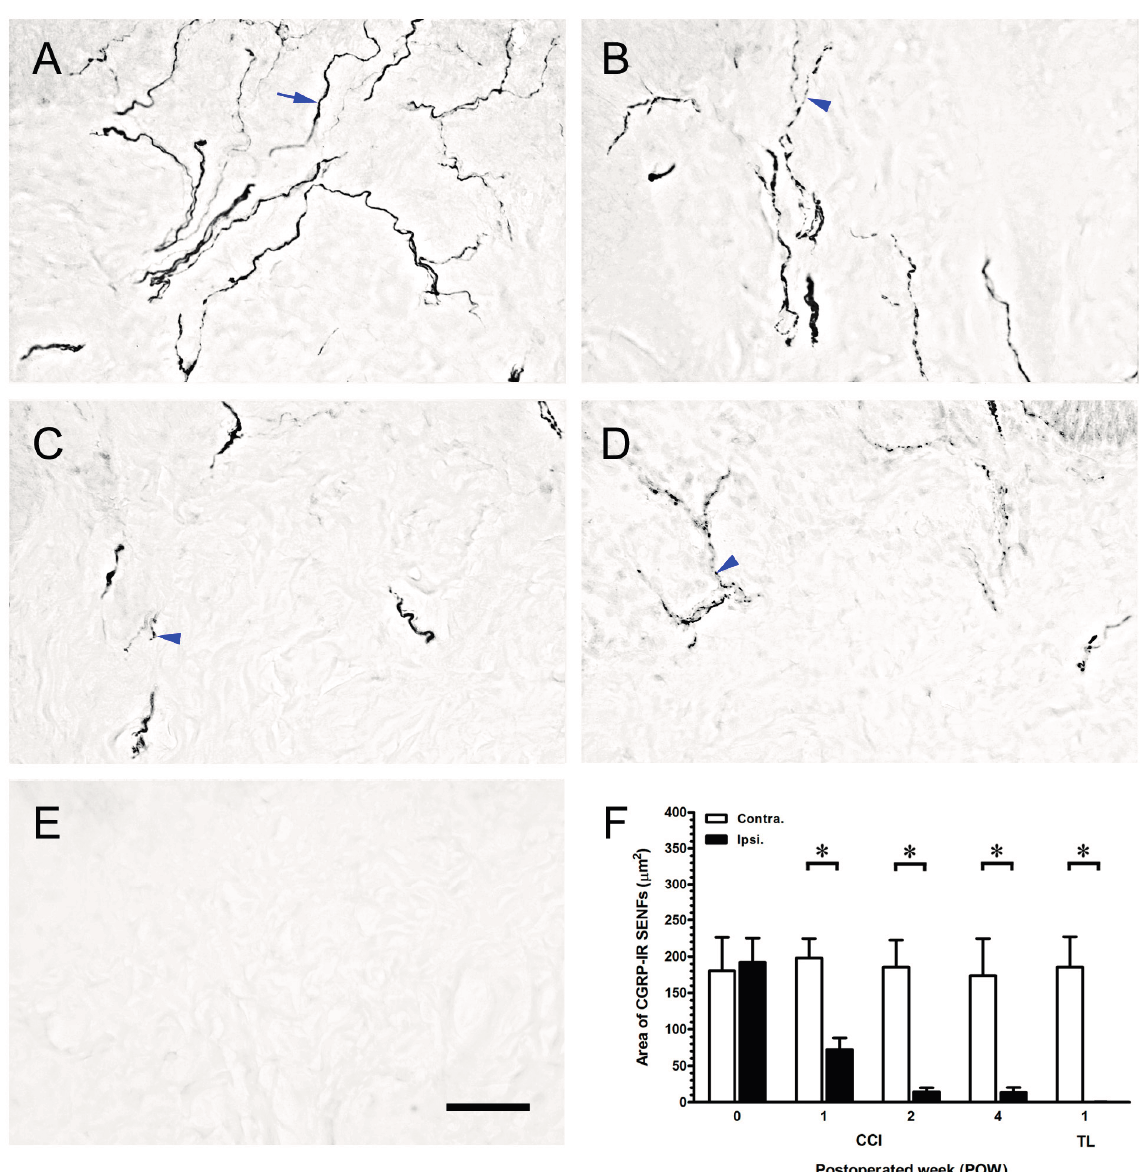
Figure 3. Influences of nerve compression injury on calcitonin gene-related peptide (CGRP)-IR SENFs in dermis. The ipsilateral sides of footpad skin from ( A ) sham-operated surgery, ( B – D ) CCI, and ( E ) TL were immunostained with antibody against CGRP. ( A ) Irregular linear CGRP-IR SENFs in normal dermis were towards the epidermal-dermal junction (blue arrow); Temporal changes of dermal expression were exposed at ( B ) POW 1, ( C ) POW 2 and ( D ) POW 4, and CGRP-IR SENFs had obvious beaded and swollen fragments after CCI (blue arrowhead); ( E ) Entire CGRP-IR SENFs loss was presented after TL at POW 1. Scale bar = 25 μ m; and ( F ) The areas of CGRP-IR SENFs were quantified as the mean ± SD ( n = 5 at each time points after CCI, n = 5 at POW 1 after TL). Each bar of values showed in the contralateral sides (Contra., open bars) and ipsilateral sides (Ipsi., filled bars). Student’s t test was applied to examine the differences between the Contra. and Ipsi. at the same time points. * p < 0.05, indicated as a significant